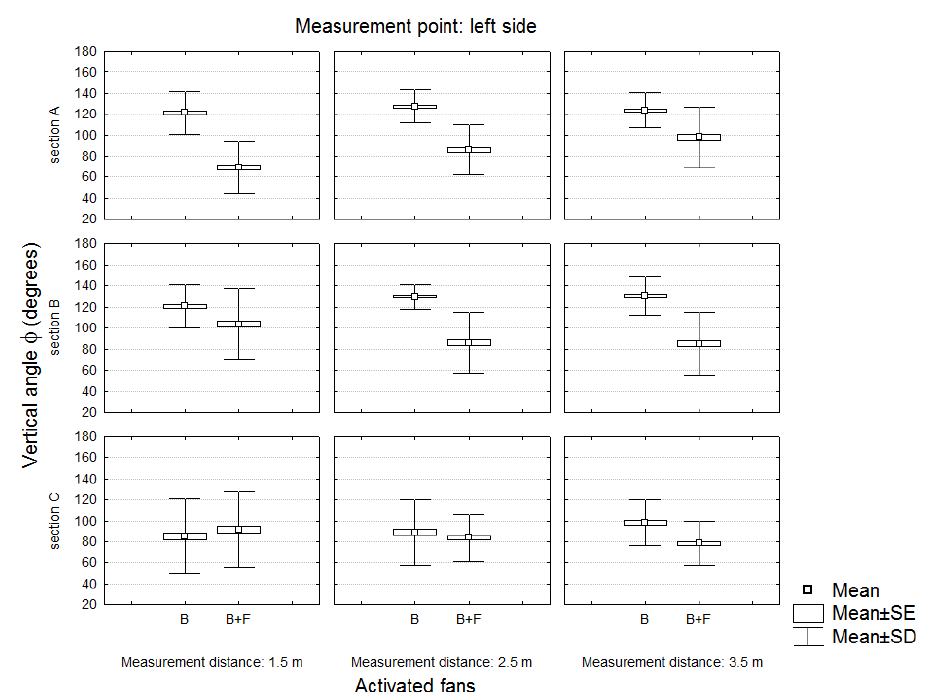
Figure 11. Vertical angle of the velocity vector according to the number of active fans and the measurement section. Values of the left working